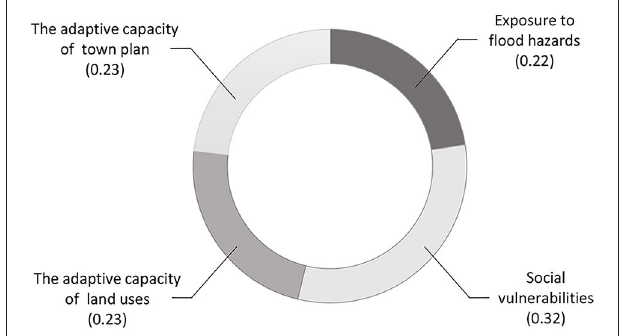
FIGURE 6 | The average weights of risk drivers, assigned by experts.